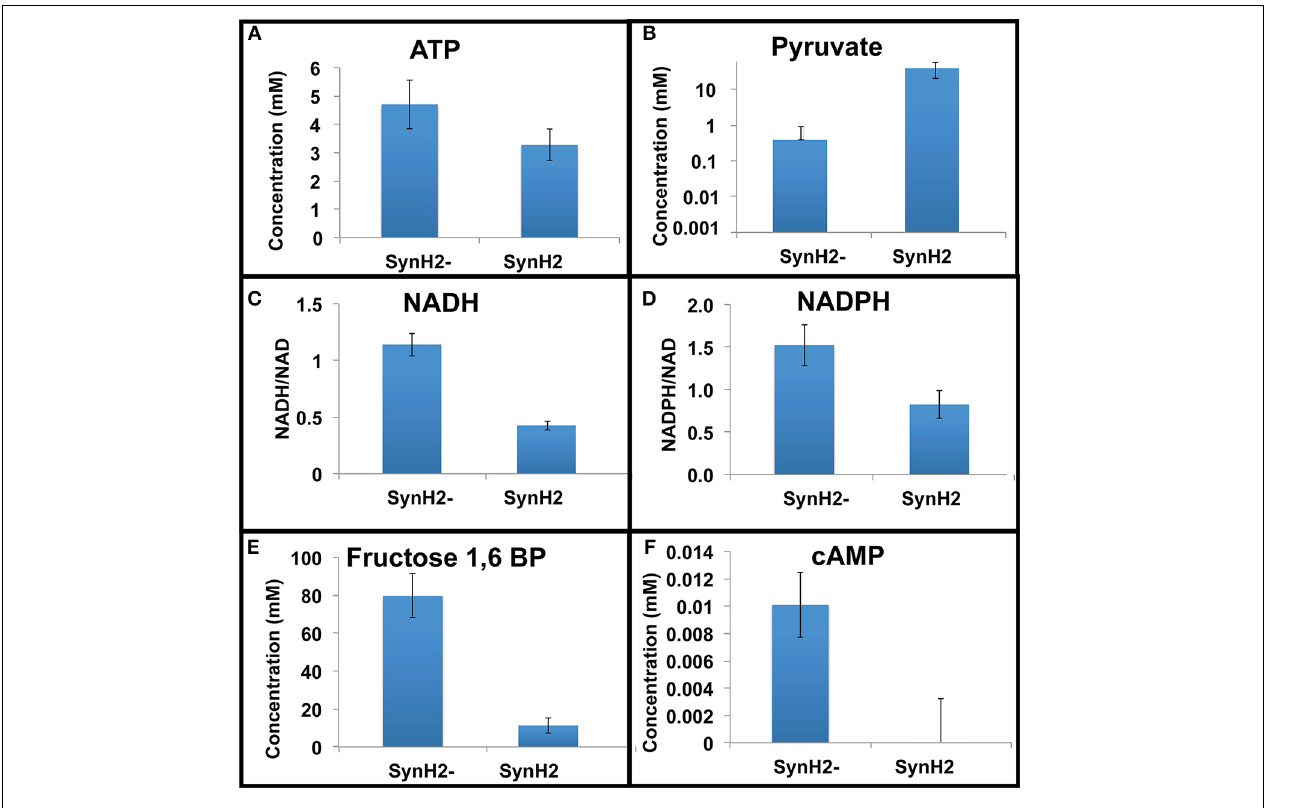
described in the Material and Methods. Shown are intracellular concentrations of ATP (A) , pyruvate (B) , fructose-1,6-bisphosphate (E) , and cAMP ( F ). (C,D) show the ratios of NADH/NAD + and NADPH/NADP + ,